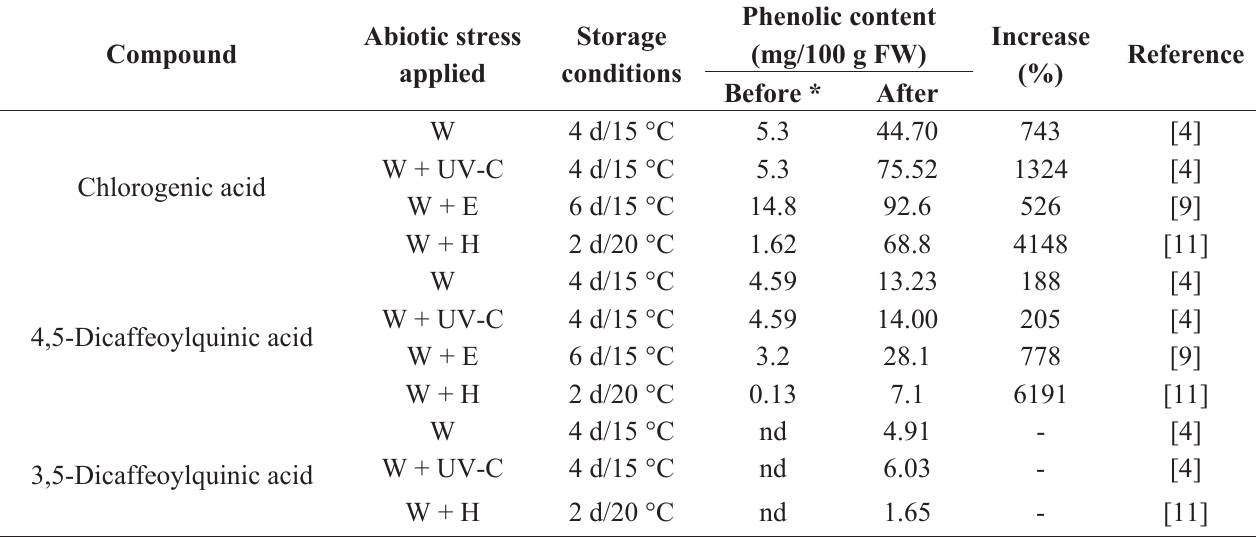
Table 1. Effect of different abiotic stresses (wounding, UV-light, ethylene, and methyl jasmonate) on the accumulation of individual phenolic compounds in